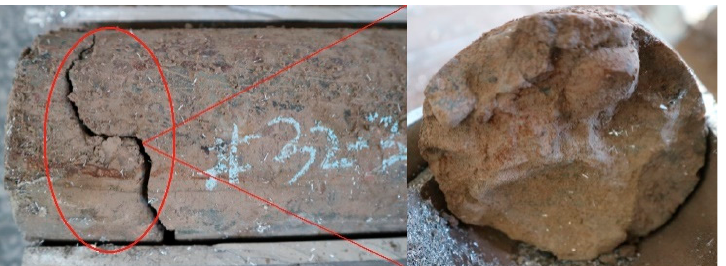
Figure 11. Drilling-induced fracture in slant core with irregular twisted fracture morphology. Frac- ture surface comprises bypassing gravel with drilling mud attached.